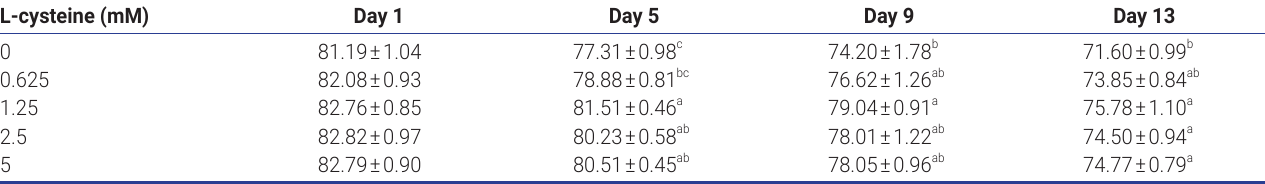
Table 2. Effects of different concentrations of cysteine on sperm progressive motility during the liquid storage L-cysteine (mM)